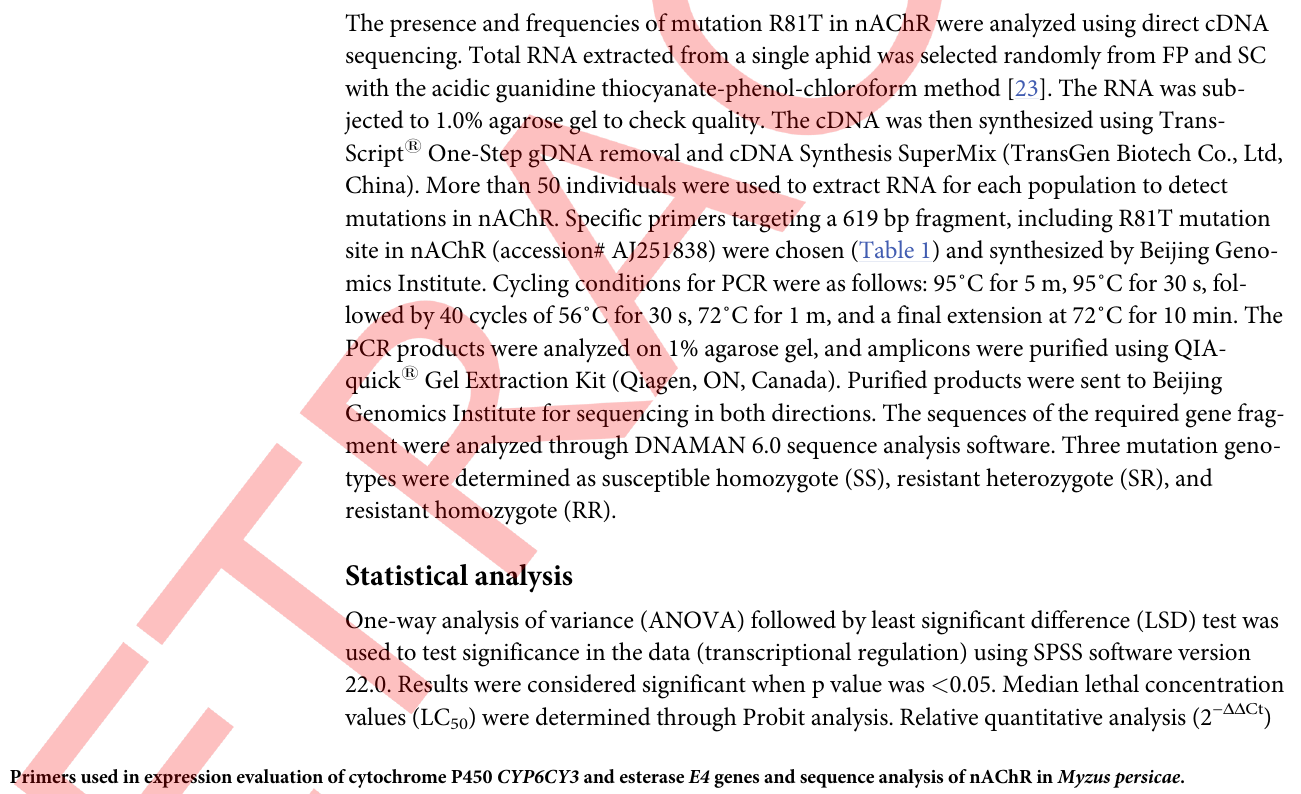
Table 1. Primers used in expression evaluation of cytochrome P450 CYP6CY3 and esterase E4 genes and sequence analysis of nAChR in Myzus persicae . Genes Primer Sequence